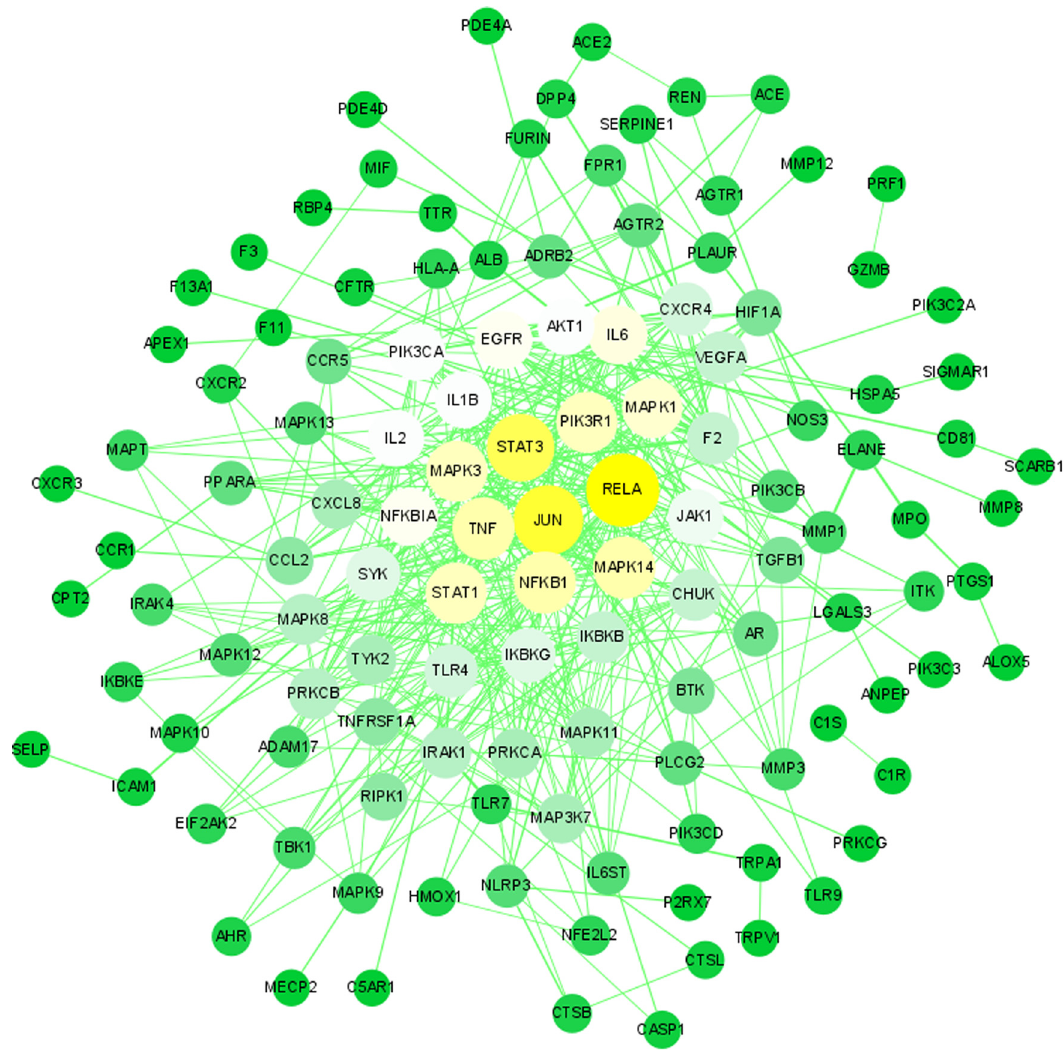
Figure 2: The PPI network of 113 targets. The size and brightness of the nodes indicate the importance of the